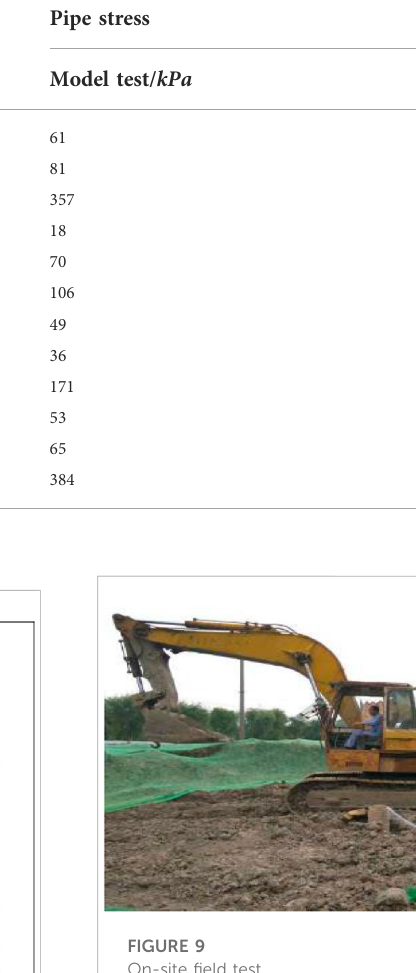
FIGURE 9 On-site fi eld